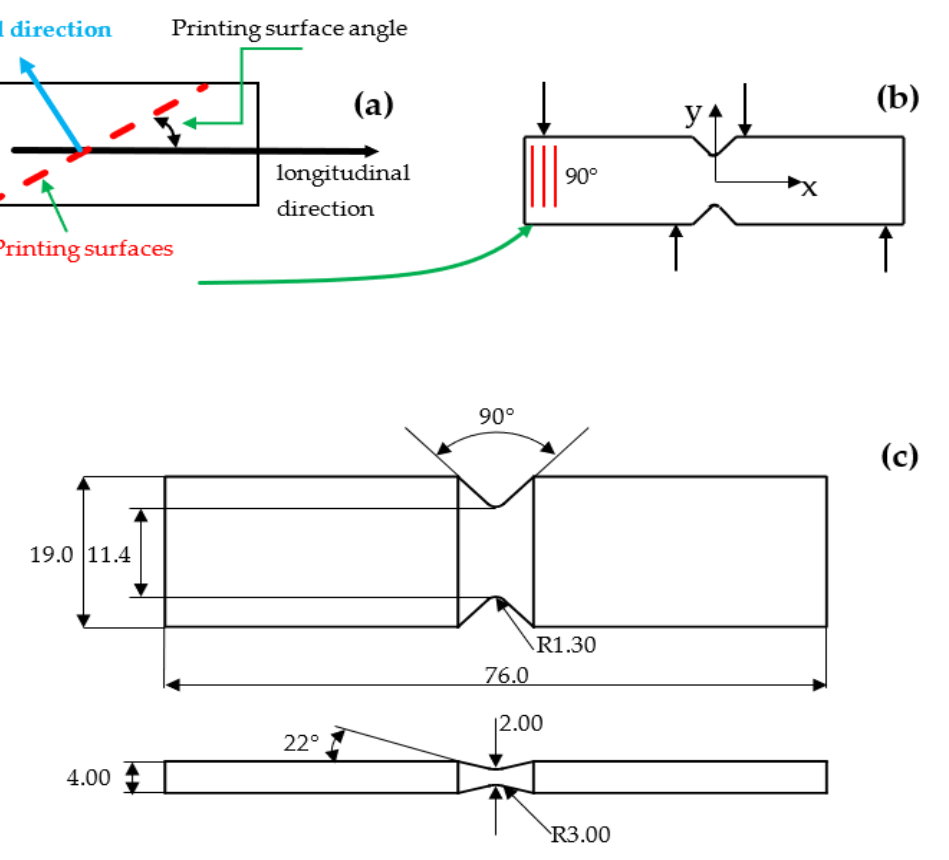
Figure 1. ( a ) Definition of the printing surface angle. ( b ) Shear specimen with a printing surface angle of 90 ◦ . ( c ) Necking-shaped shear specimen with a variable central cross-section (all dimensions in